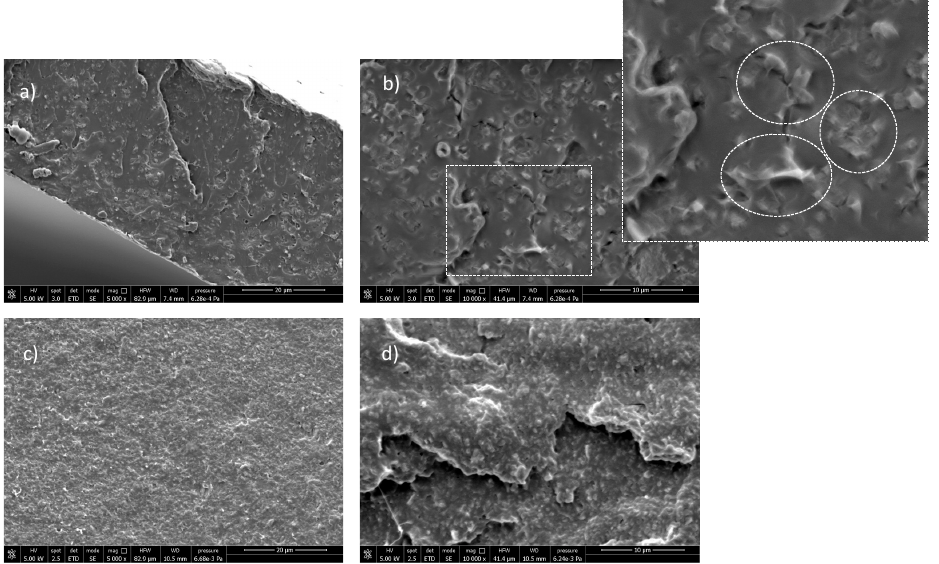
Figure 6. SEM images at different magnifications of PLA/LDH-DS/RA (( a ) and ( b )) and PLA/LDH- DS/GA (( c ) and ( d )).